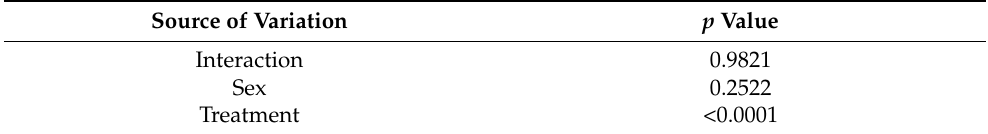
Table 6. Statistical table of the individual effects and interactions of rat sex and treatment on cardiac MPO activity.